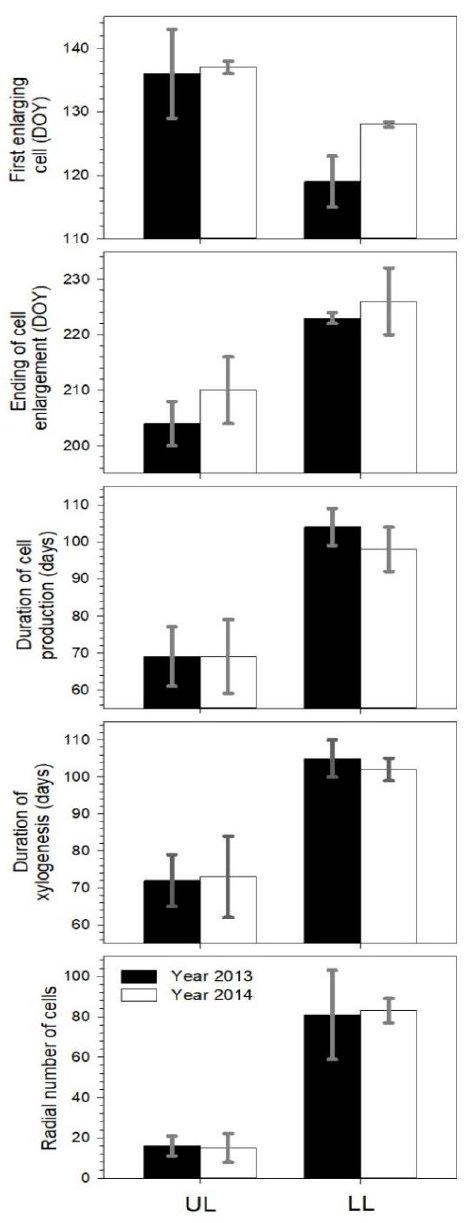
Figure 5. Timings and duration of xylem formation and cell production observed at UL and LL during 2013 and 2014. Error bars indicate standard deviations among trees. Table 2. ANOVA results comparing timings and duration of xylogenesis and cell production between sites, years, and their interaction.